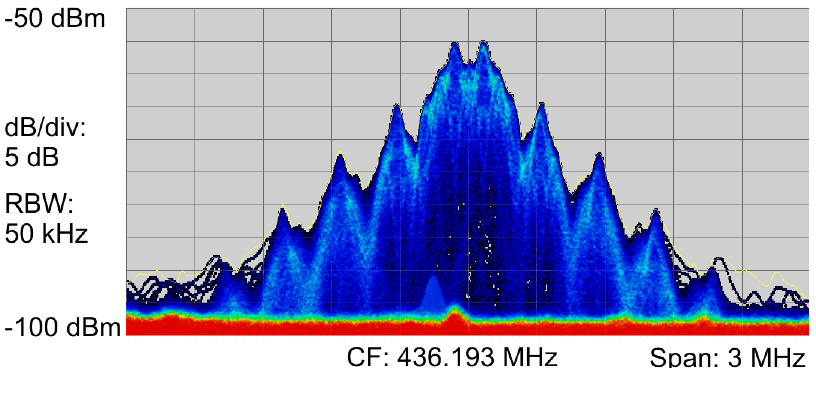
Figure 8. Measured power spectrum of the MSK modulated signal with a PN-generated random payload and a resolution bandwidth (RBW) of 50 kHz.